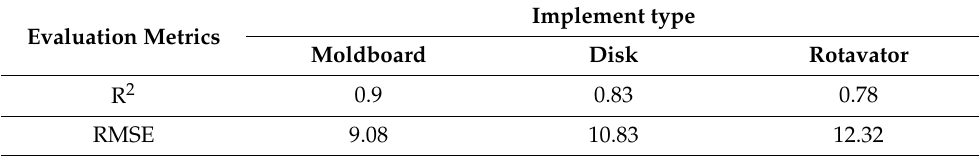
Table 2. Values of regression equation of the proposed method in estimation of soil surface roughness. Evaluation